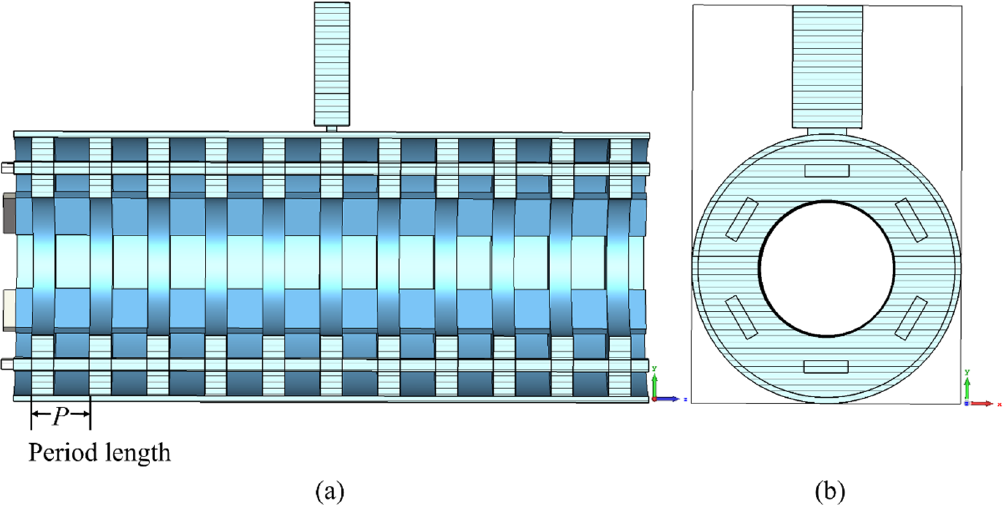
Figure 3. Cross-sectional view of the multiple sheet beam EIO in the ( a ) y–z plane and ( b ) x–y plane. Figure 4 is the dispersion diagram of the proposed EIO with different TM